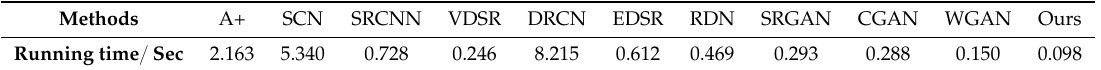
Table 5. Comparison of running time for 4 ˆ in our